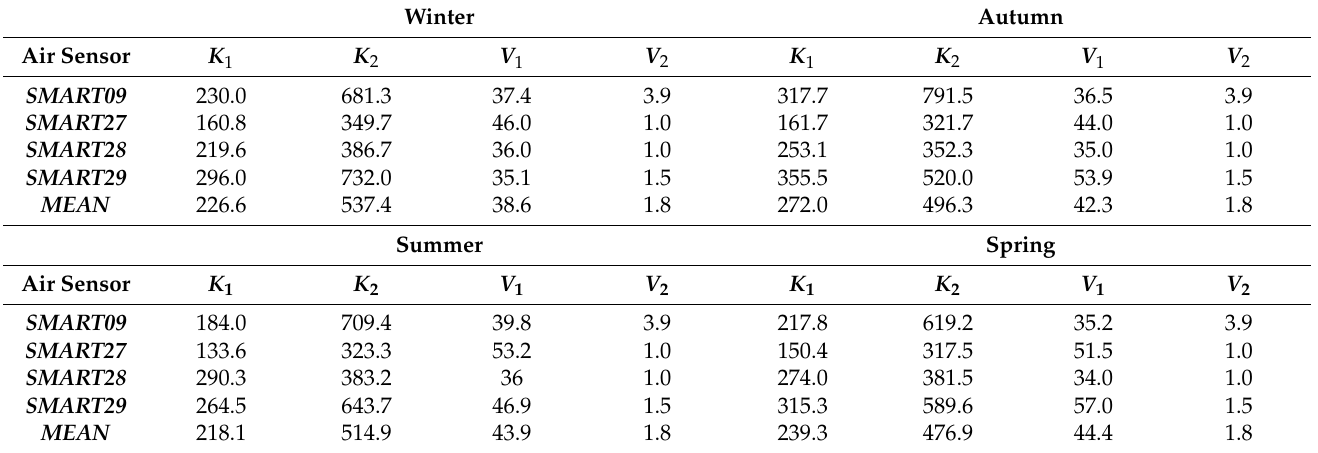
Table 4. Summarising numerical results by means of the applied model to identify the desired emissions factors in case of uncongested and congested traffic situations in different periods of the year for different sensor